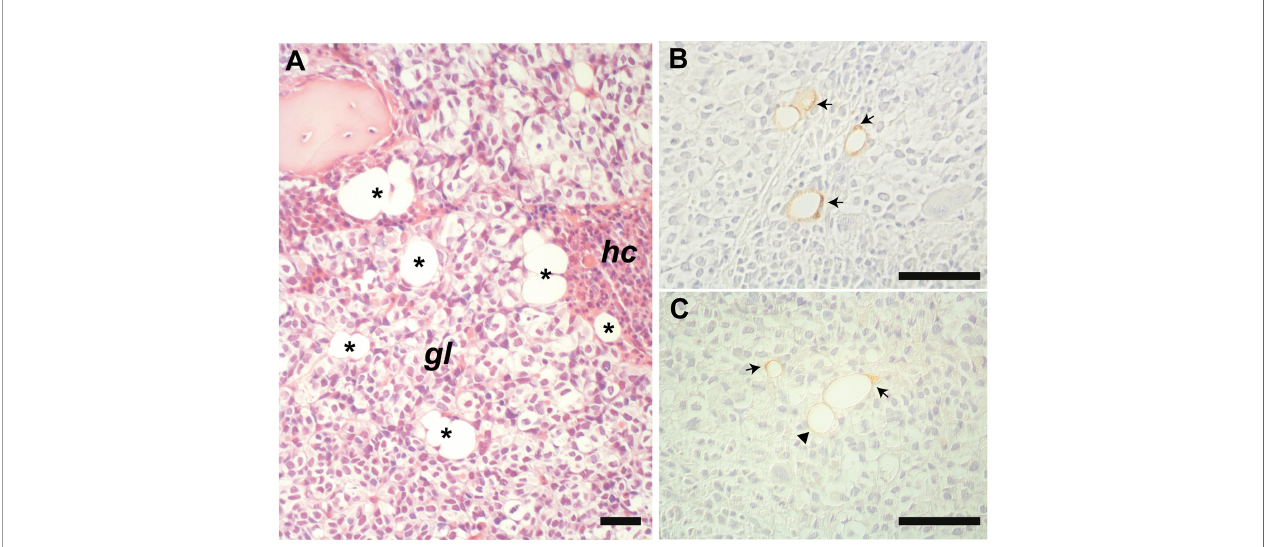
FIGURE 3 | Representative histological image of the marrow metastasis of glioma (A) . BMAds (asterisks) are intercalated among the neoplastic cells ( gl ) and the haematopoietic cells ( hc ). Immunostaining for PLIN1 (B) and ADIPOQ (C) highlights intra-tumoral “ remodeled ” BMAds containing very small intracytoplasmic lipid droplets clustered together and polarized beneath the plasma membrane (arrows), which are not observed in morphologically typical unilocular adipocyte (arrowhead). Panel (A) : HE stain. Scale bars: 50